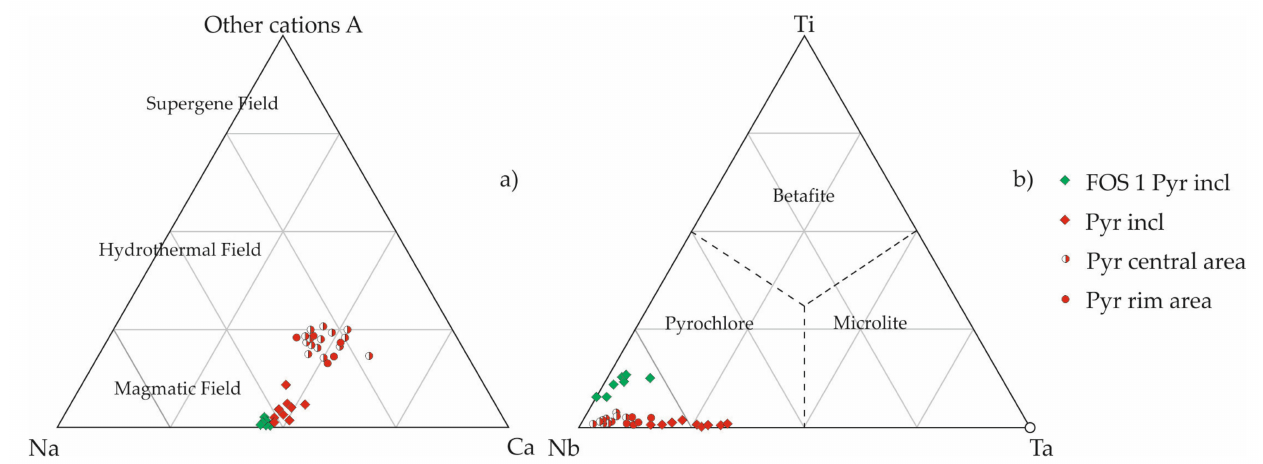
Figure 8. Variations in the chemical composition of pyrochlore in the Arbarastakh massif ( a ) position A (according to [42]), ( b ) position B.